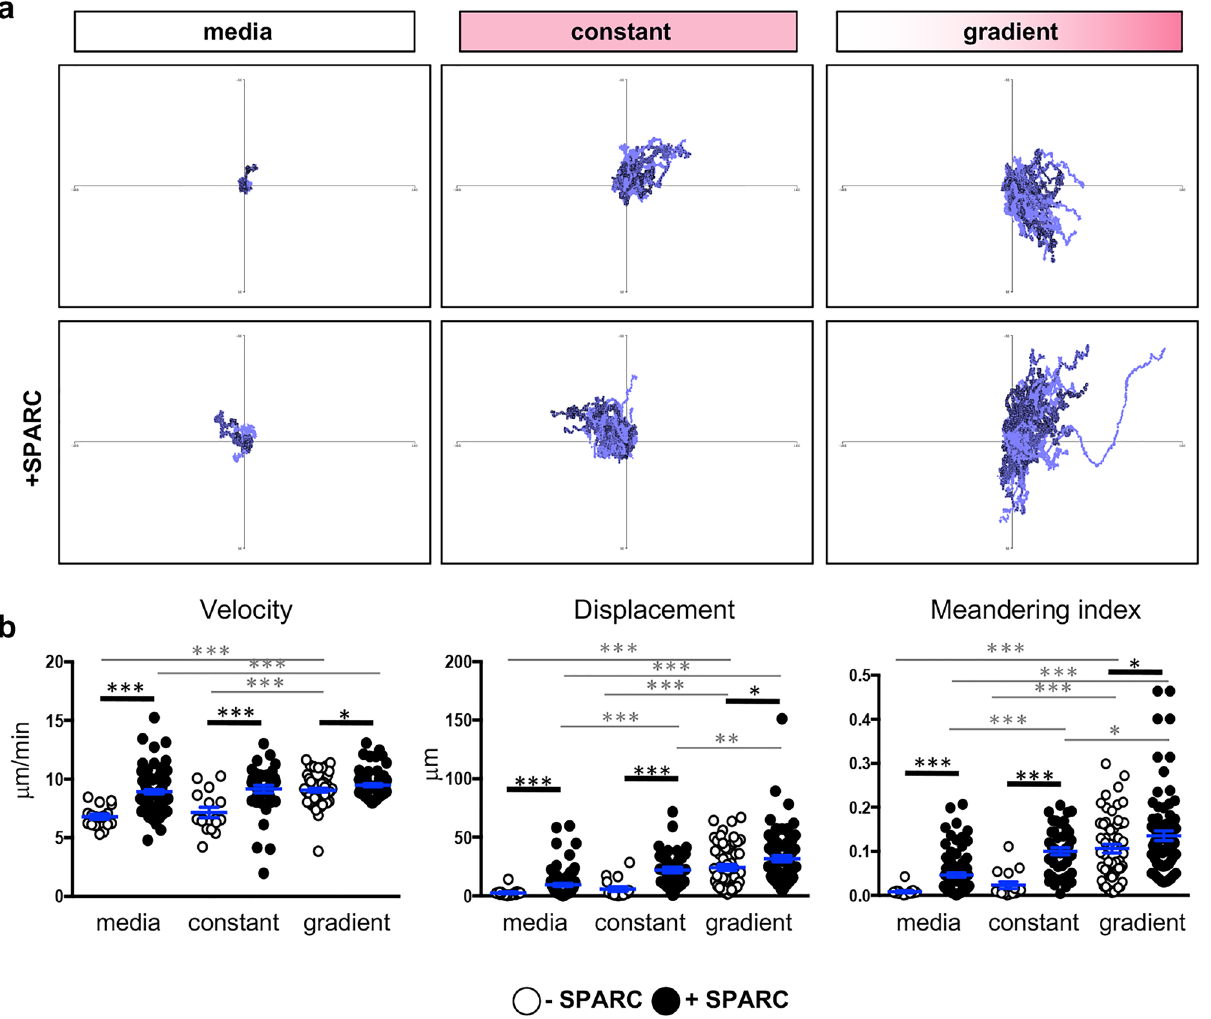
Figure 5. T cell migration is enhanced in the presence of SPARC in vitro. dsRed + T cells were seeded in matrigel in the presence or absence of SPARC and the presence or absence of recombinant CCL21. Cell migration was imaged over 20 min in response to no chemokine, a constant concentration of chemokine, or a chemokine gradient. Videos of cell migration were analyzed. ( a ) Tracks of T cells migrating in response to media alone, a constant chemokine field, or in response to a gradient of CCL21 were normalized to begin at the origin to visualize migration trends. ( b ) Cell velocity, displacement, and meandering index were quantified using Volocity software and migration data was analyzed using the Mann–Whitney test. Data are representative of at least 2 individual experiments and are represented as mean ± SEM. Thick black lines indicate comparisons + / − SPARC, thin grey lines indicate comparison + / − chemokine. To simplify, only significant comparisons are annotated * p < 0.05, *** p <